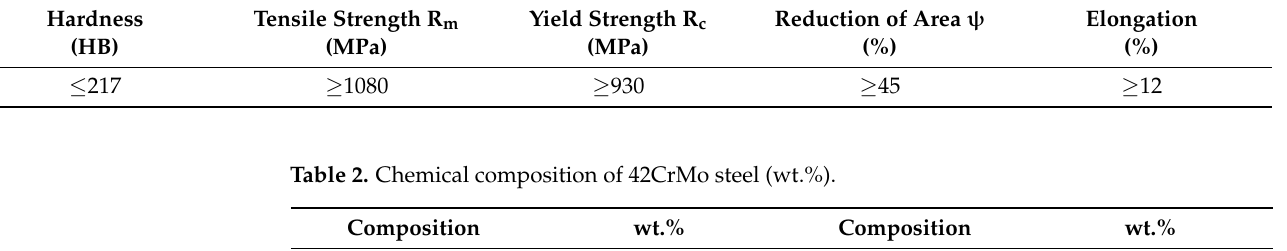
Table 1. Mechanical behavior of 42CrMo steel.